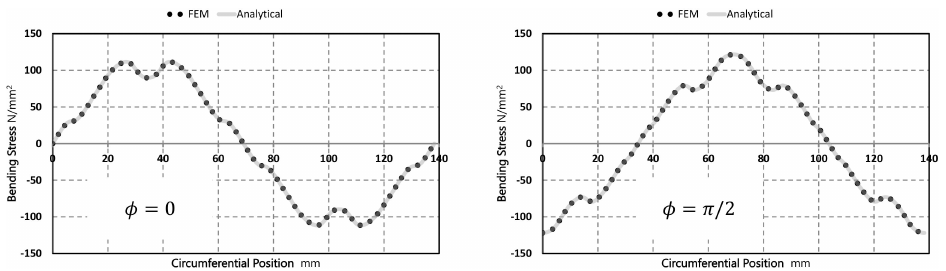
Figure 8. FE mesh and boundary conditions for the M-T04 profile. The stress distribution is determined for two angles of rotation ( φ = 0 and φ = π /2) using Equation (52) and compared with the results of the finite-element (FE) analyses in Figure 9, where M b = 500Nm. As shown, the results agree well.